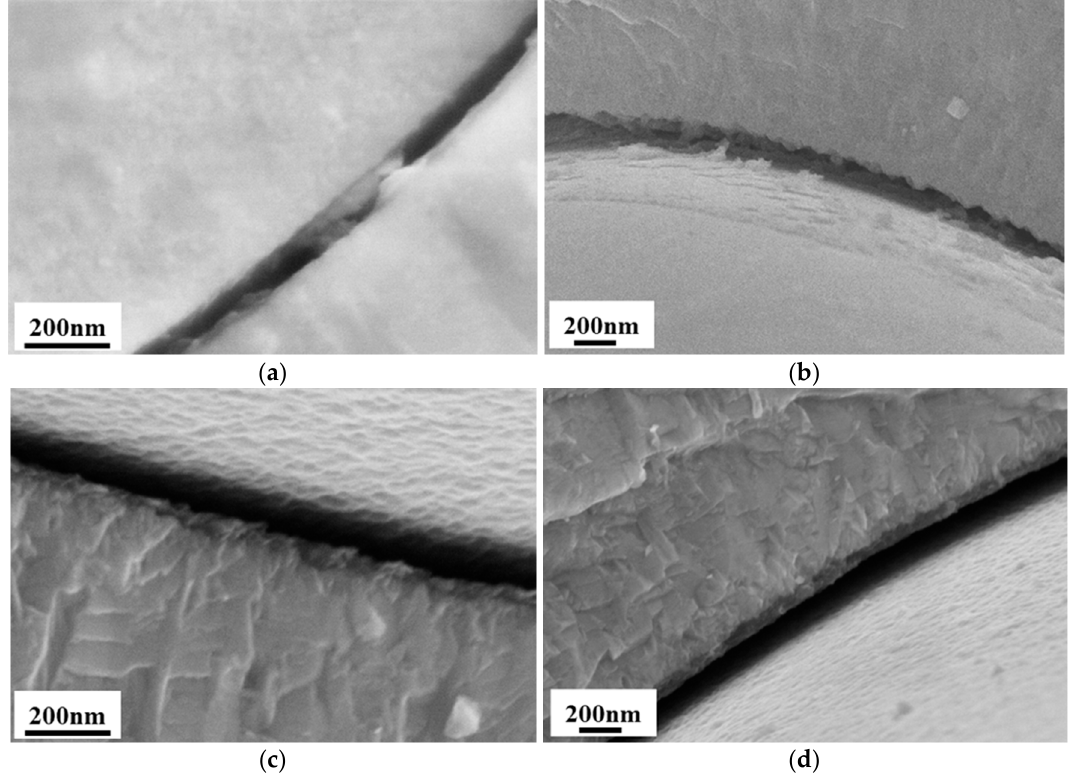
Figure 11. High magnification SEM micrographs of typical F/M debonding zone after failure for each type of composites specimen: ( a ) HNS/PyC HA30nm /SiC, ( b ) HNS/PyC HA150nm /SiC, ( c ) HNS/PyC LA30nm /SiC and ( d ) HNS/PyC LA150nm /SiC. ( c ) HNS/PyC LA30nm /SiC and ( d ) HNS/PyC LA150nm